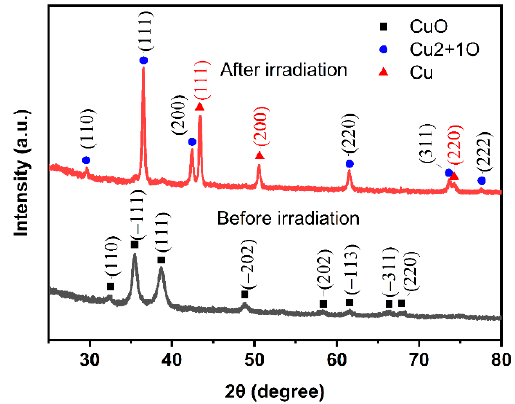
Figure 6. XRD patterns of the ink before and after laser irradiation.